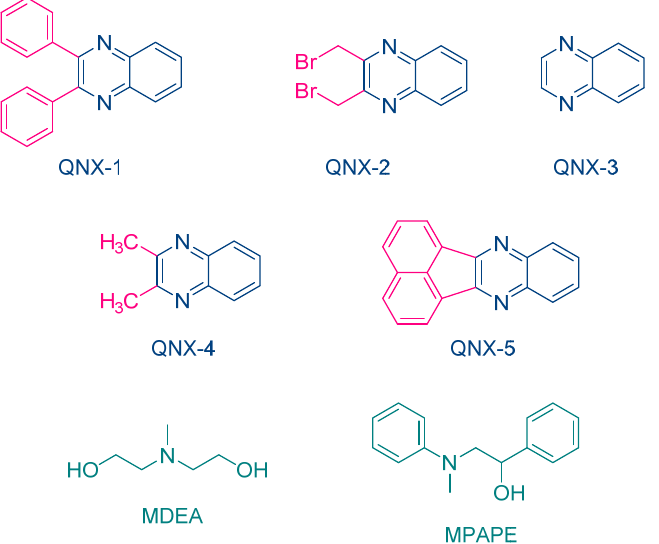
Figure 3. Chemical structures of different quinoxaline derivatives investigated by Aydin and coworkers as photoinitiators of polymerization in combination with MDEA and MPAPE.